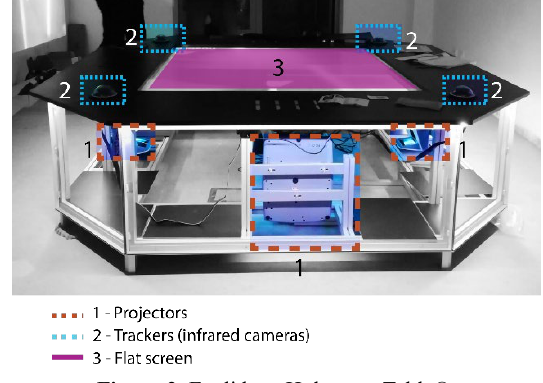
Figure 2. Euclideon Hologram Table©.